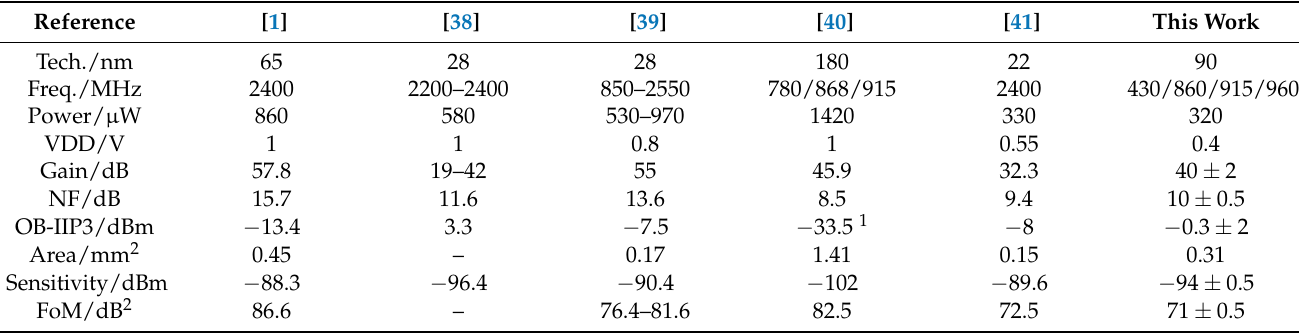
Table 2. Performance summary and benchmark with the state-of-the